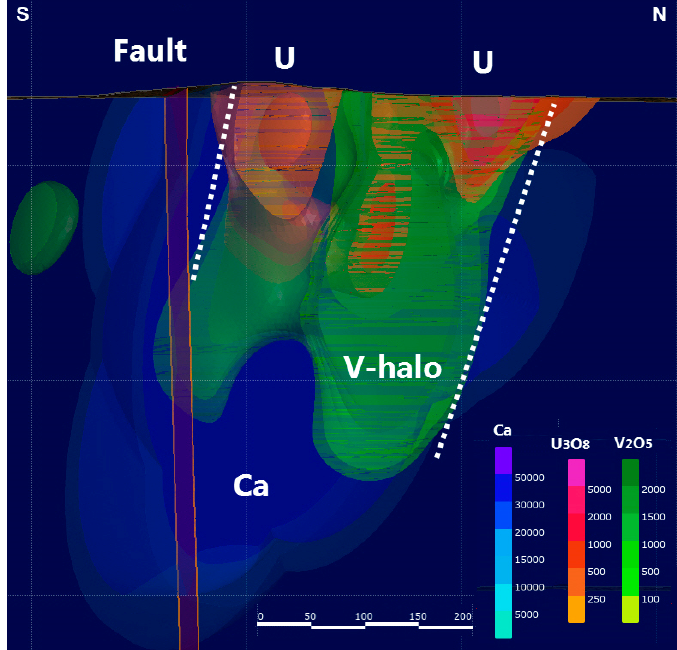
Figure 4. Three-dimensional model showing the distribution of U, V and Ca in a cross-section through Anomaly-15 (see Figure 3 for location). U mineralization shells in red, V mineralization shells and the V-halo in green, and the Ca-rich envelope (calcite-cemented sandstone) in blue. The white dashed lines show the steeply dipping upper and lower stratigraphic contacts of host grey sandstone, and the red vertical line is a modeled fault plane. The depth of the section below surfaces as shown is approx. 250